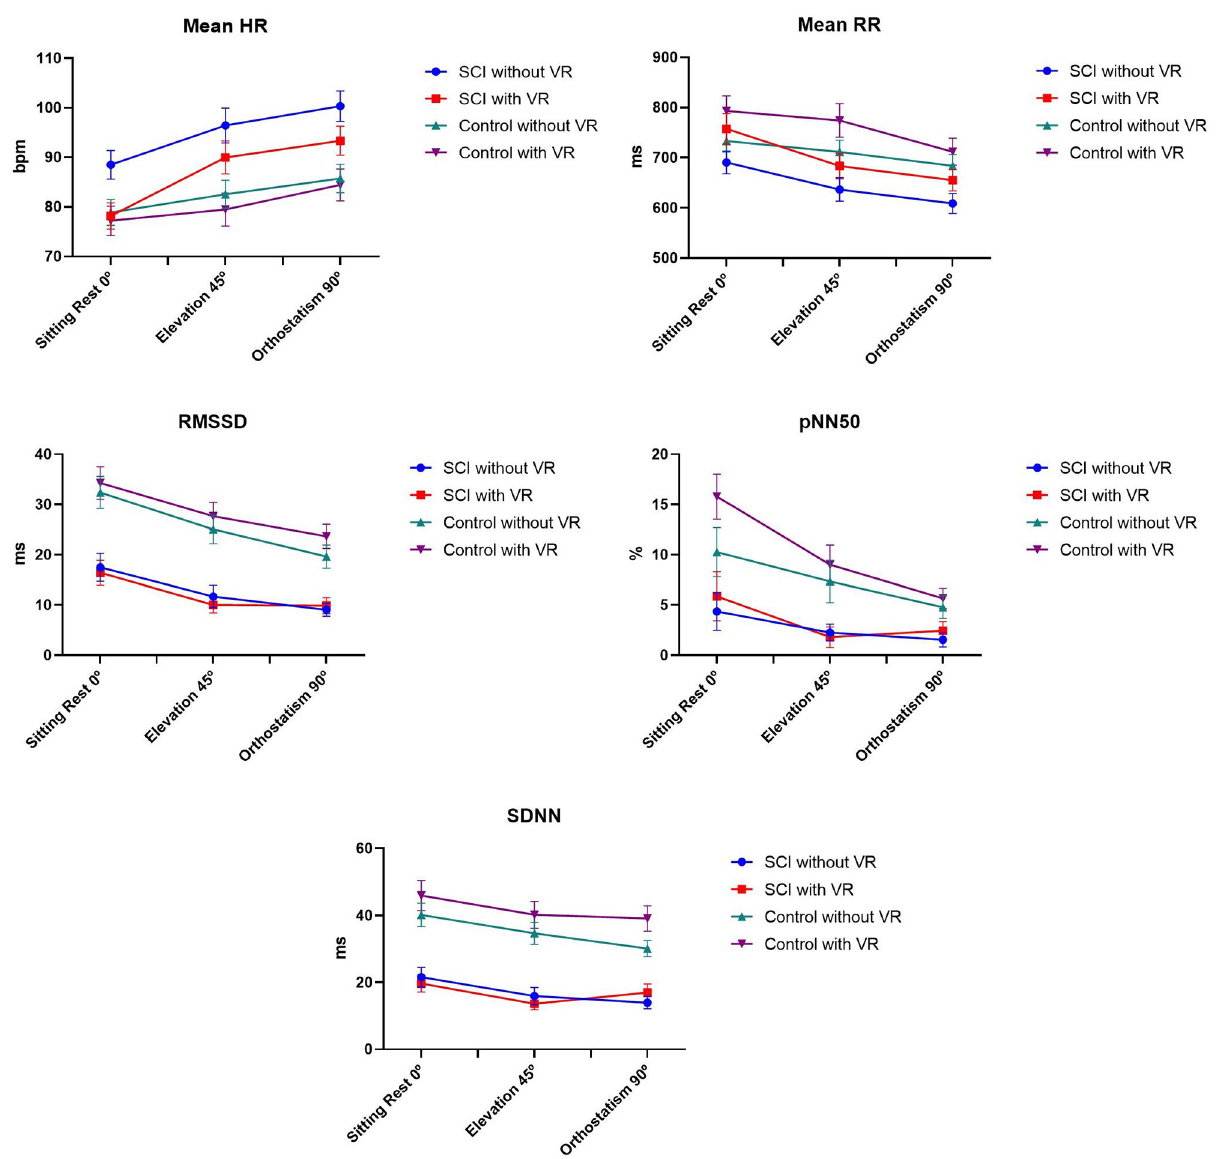
Fig 3. Representation of the mean and standard error of the time domain indices for SCI and able-bodied controls, at the three moments (Sitting rest 0˚, elevation 45˚, and orthostatism 90˚), with and without virtual reality. SCI: spinal cord injury; VR: Virtual Reality activity; bpm: beats per minute; ms: millisecond; HR: heart rate; RR intervals: intervals between heartbeats; RMSSD: square of the root mean difference of successive RR intervals; pNN50: percentage of adjacent RR intervals with a difference in duration greater than 50 milliseconds; SDNN: standard deviation of the mean of all RR intervals over a